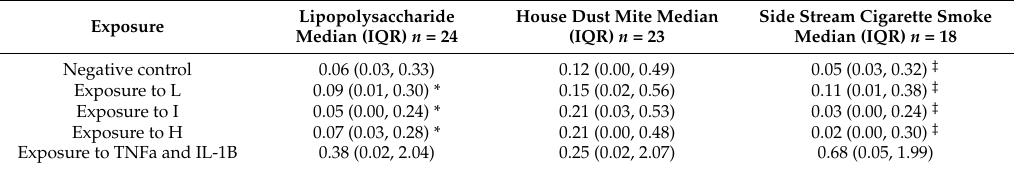
Table 4. Median and interquartile range [IQR] concentrations of granulocyte macrophage colony stimulating factor in supernatants from bronchial airway epithelial cell culture after exposure to lipopolysaccharide (L = lowest concentration = 1 µ g/mL, I = intermediate concentration = 10 µ g/mL and highest concentration = 100 µ g/mL), house dust mite (L = lowest concentration = 5 µ g/mL, I = intermediate concentration = 25 µ g/mL and H = highest concentration = 50 µ g/mL) and side stream cigarette smoke (concentrations the same as for house dust